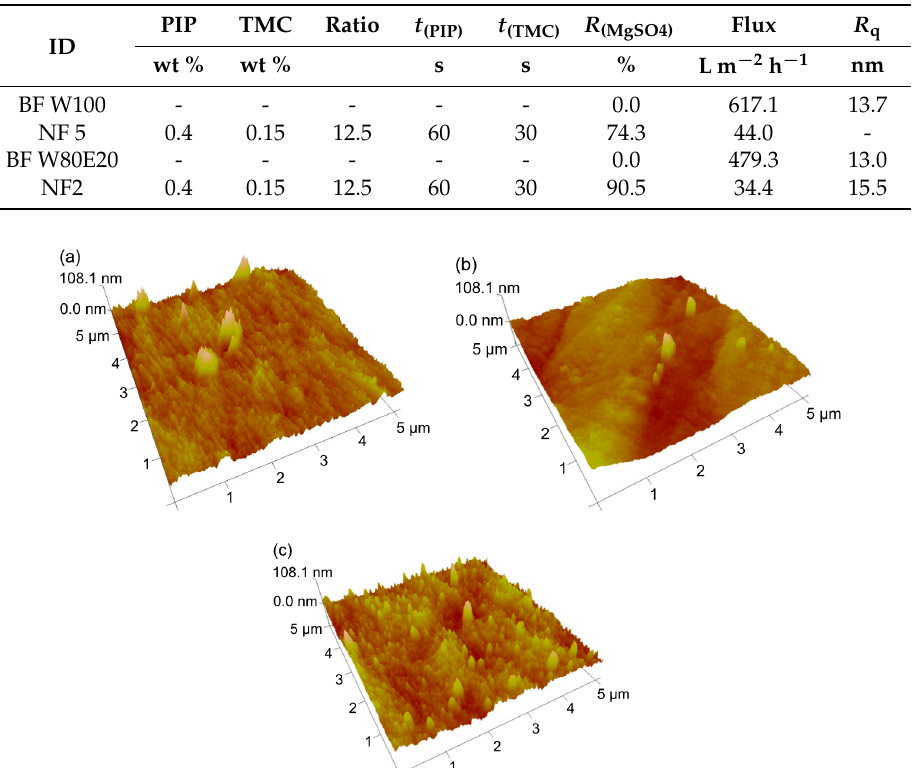
Table 3. Effect of different bore fluid compositions, showing monomer ratio (PIP/TMC), reaction time ( t ), retention ( R ), and flux of uncoated and composite MCM; TMP = 2 bar.